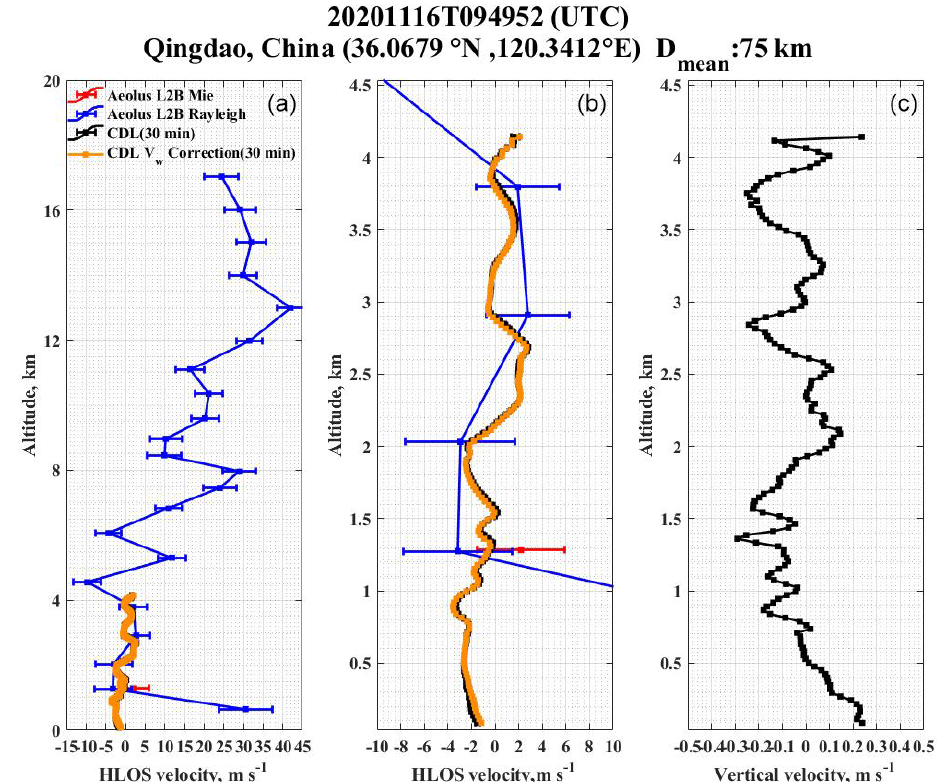
Figure 7. Inter-comparison of HLOS wind velocities measured with CDLs and Aeolus on 16 November 2020 at Qingdao (Shandong Province), China. Panel (a) is the overall view of the inter-comparison result, where the red line represents the Aeolus L2B Mie-cloudy HLOS wind profile, the blue line represents the Aeolus L2B Rayleigh-clear HLOS wind profile, the black line represents the CDL-retrieved HLOS wind profile, and the yellow line represents the vertical-velocity-corrected CDL-retrieved HLOS wind profile. Panel (b) shows the partial view of the inter-comparison result; the lines are the same as panel (a) . Panel (c) is the vertical velocity